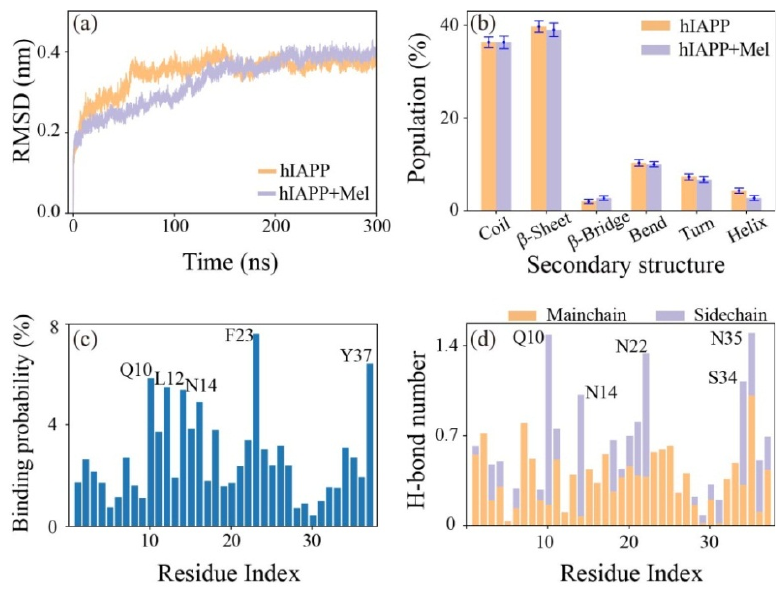
Figure 7. Analysis of the interactions between the hIAPP 1–37 fibrillar octamer and Mel. ( a ) The average time evolution of C α‐ atom RMSD without/with Mel. ( b ) The population of different secondary structures with error bars without/with Mel. ( c ) The binding probability of Mel to individual residues. ( d ) The number of H ‐ bonds formed by Mel with the main chain and side chain of each residue.